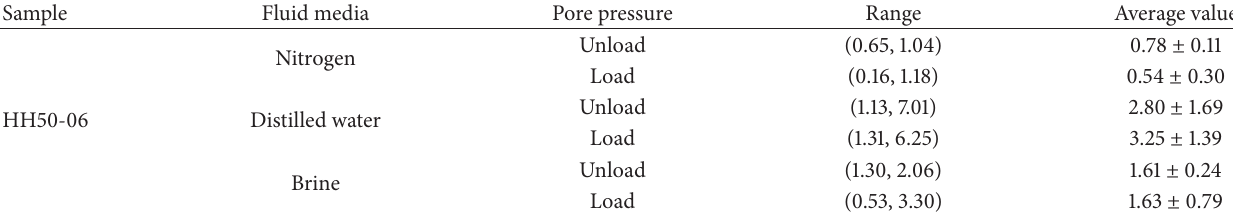
Table 3: Results of ESCK measured by three different fluid